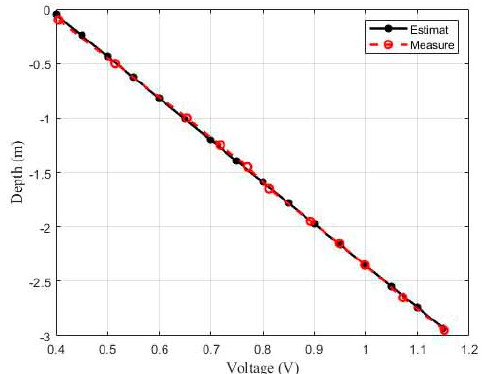
Figure 7. Actual depth vs. estimated depth. Table 2. Technical specifications of the P51 pressure sensor.